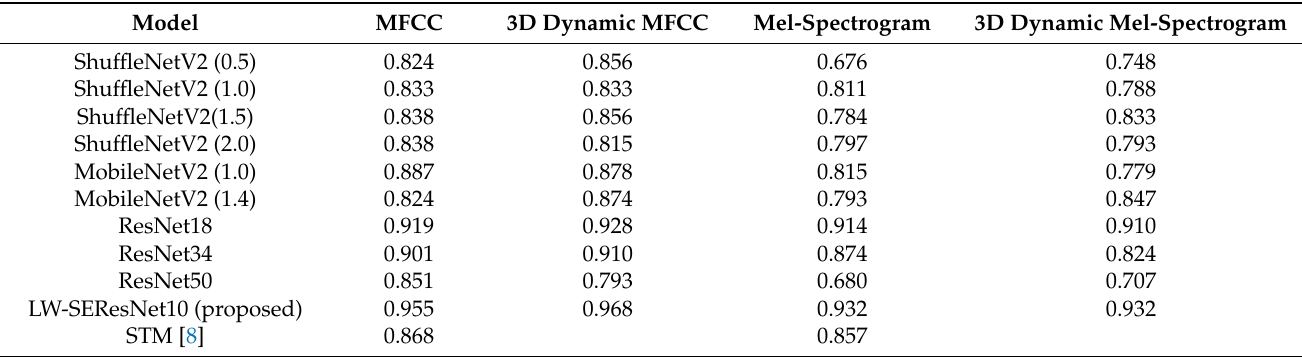
Table 6. The testing accuracy of the multiple network models under different